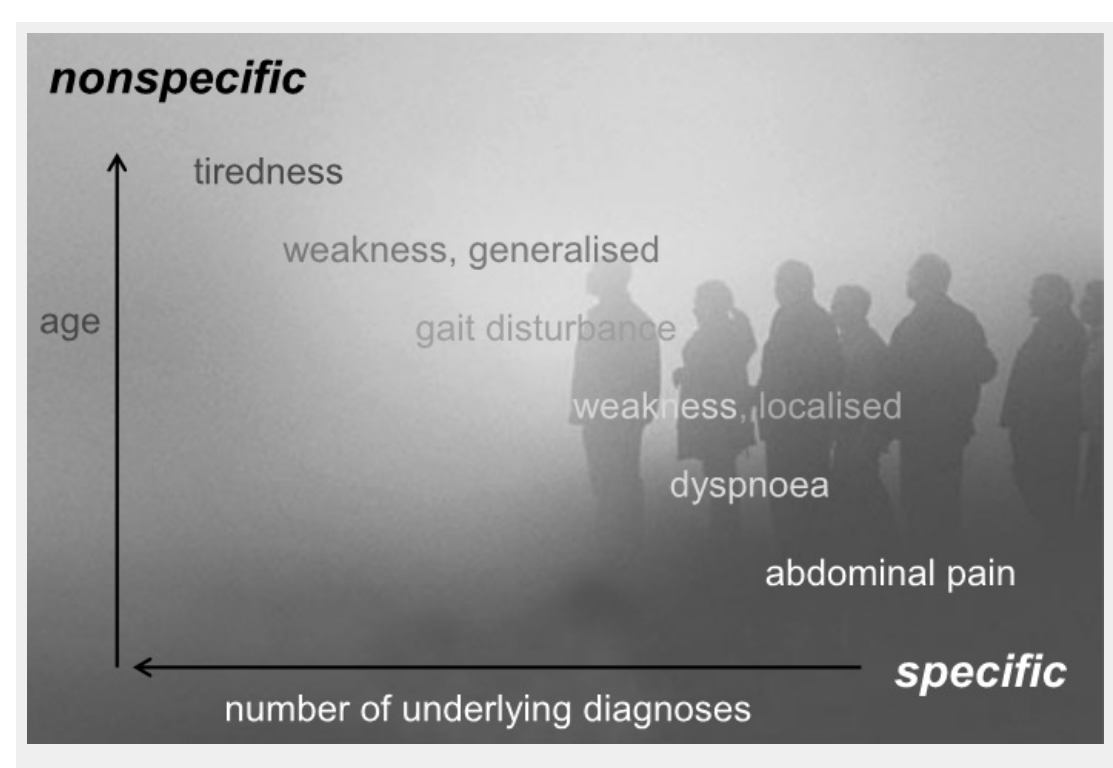
Figure 1 Specific and nonspecific presenting